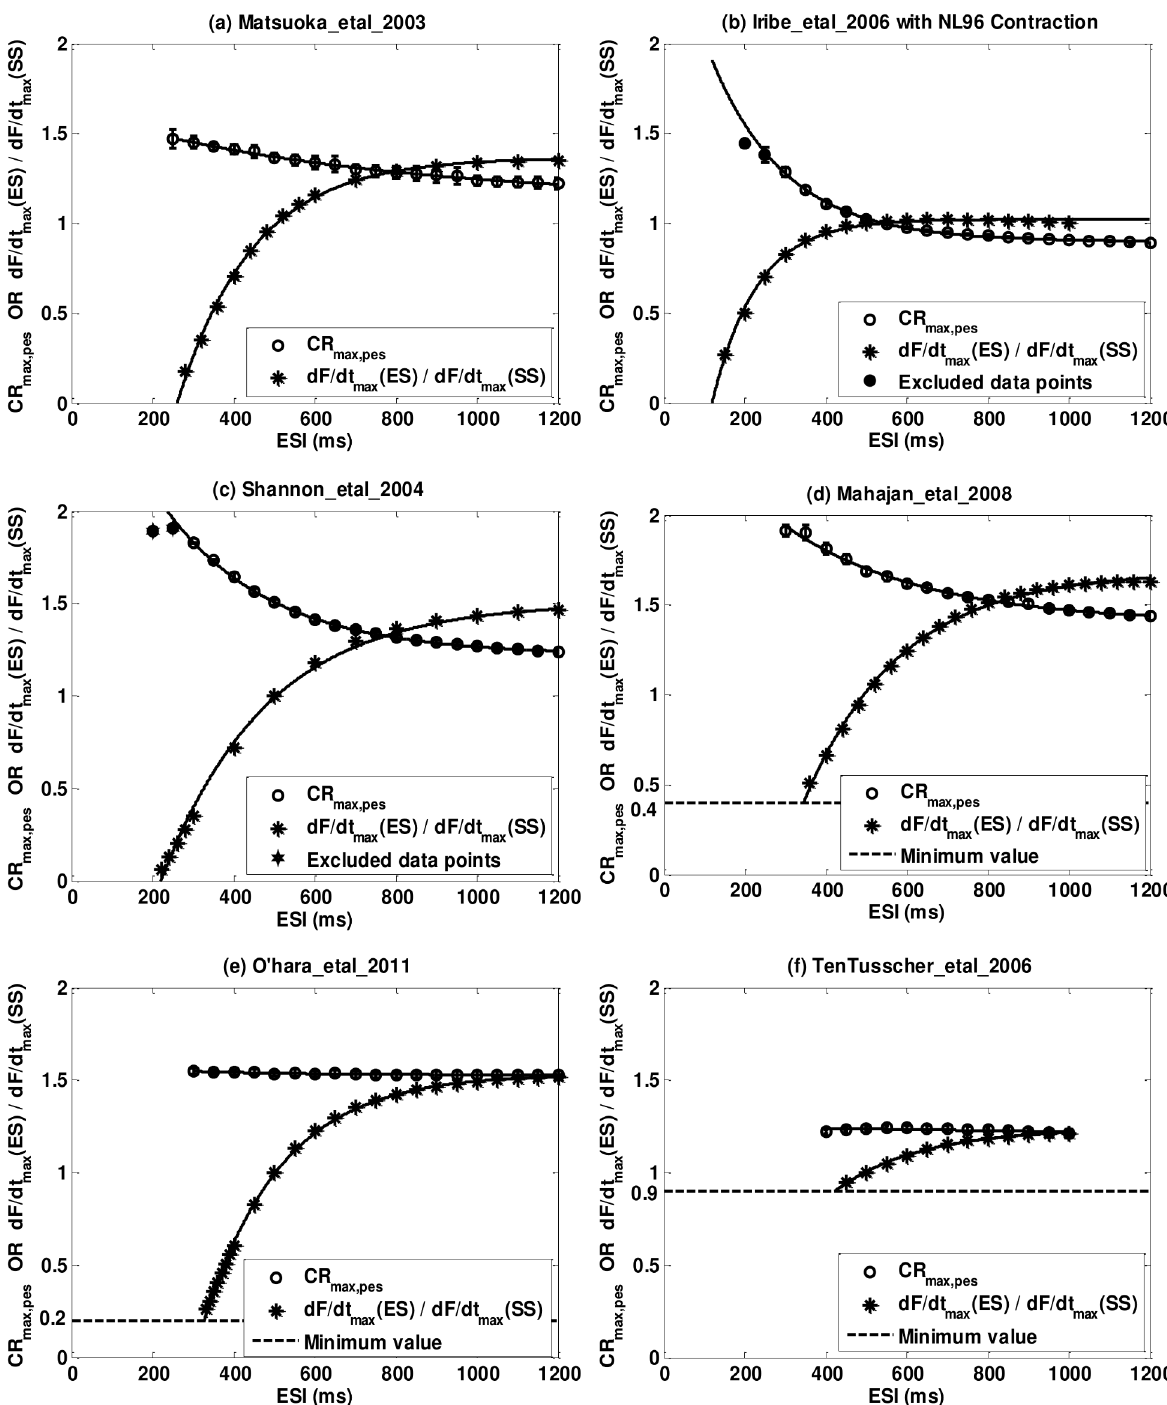
Fig 8. Representative postextrasystolic potnetiation curve (PESPC, circles o) and extrasystolic mechanical restitution curve ( MRC es , stars * ) for six models. (a) Matsuoka_etal_2003; (b) Iribe_etal_2006; (c) Shannon_etal_2004; (d) Mahajan_etal_2008; (e) O ’ hara_etal_2011; (f) TenTusscher_etal_2006. 95% confidence bounds of CR max, pes are plotted as error bars on PESPC but since the confidence bounds are small compared to the entire scale, they are not clearly observed in the figures.